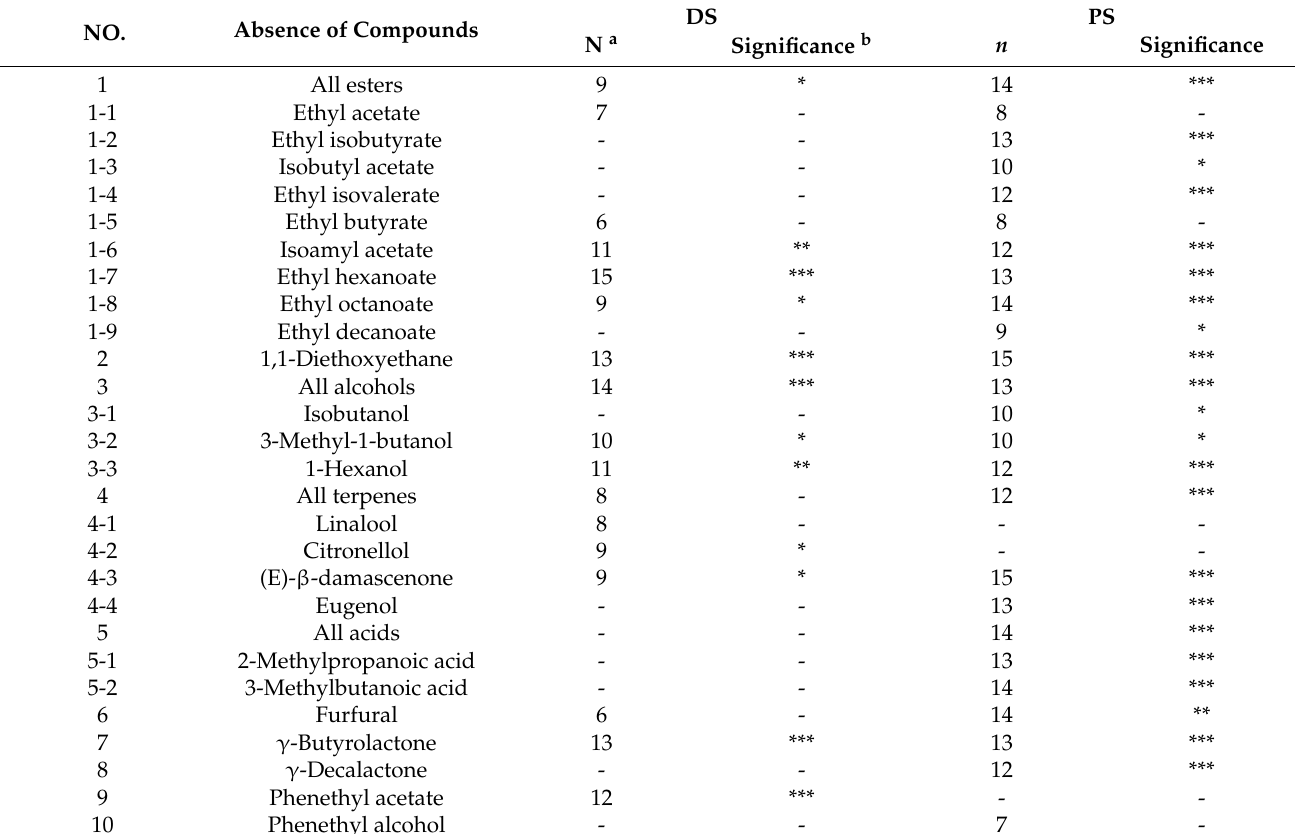
Table 3. Results of omission experiments from